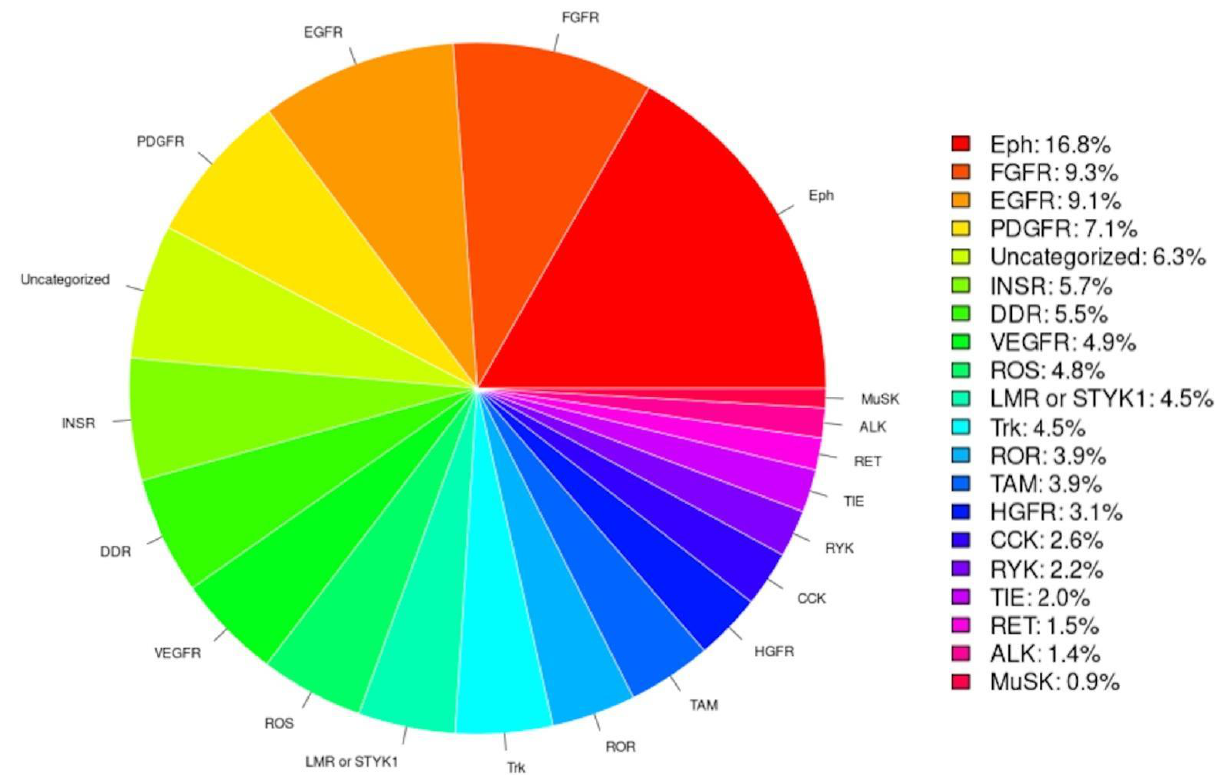
Figure 2. The pie chart is based on the classification of the RTKs by RTK-PRED, not including the manual addition nor the correction of the misclassifications of certain human RTKs.